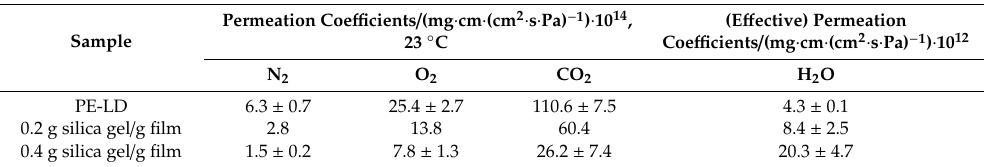
Table 6. E ff ective permeation coe ffi cients calculated from results of sorption experiments in comparison to the measured steady state permeation coe ffi cients at 23 ◦ C; error bar: Maximal deviation from mean value.